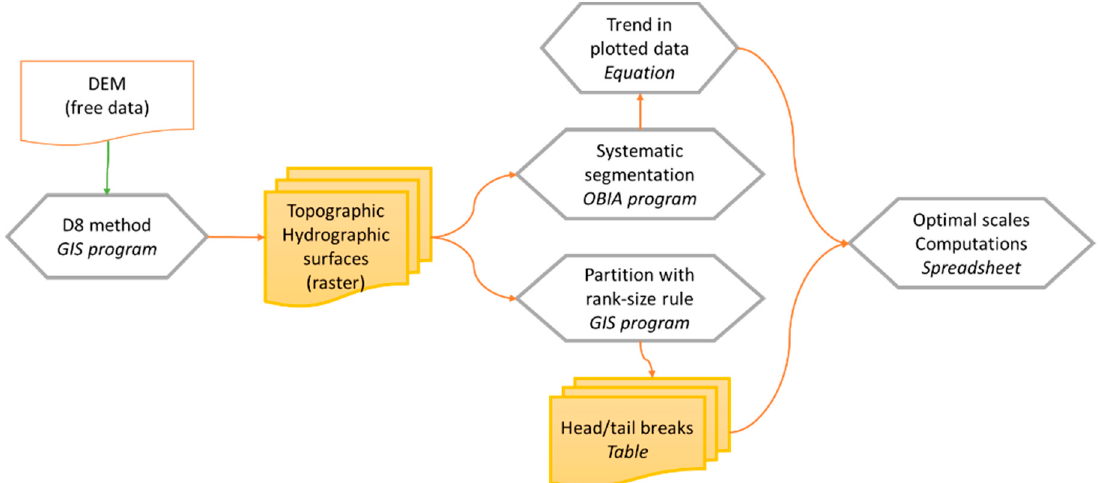
Figure 2. An overview of the computational procedure of the new method.